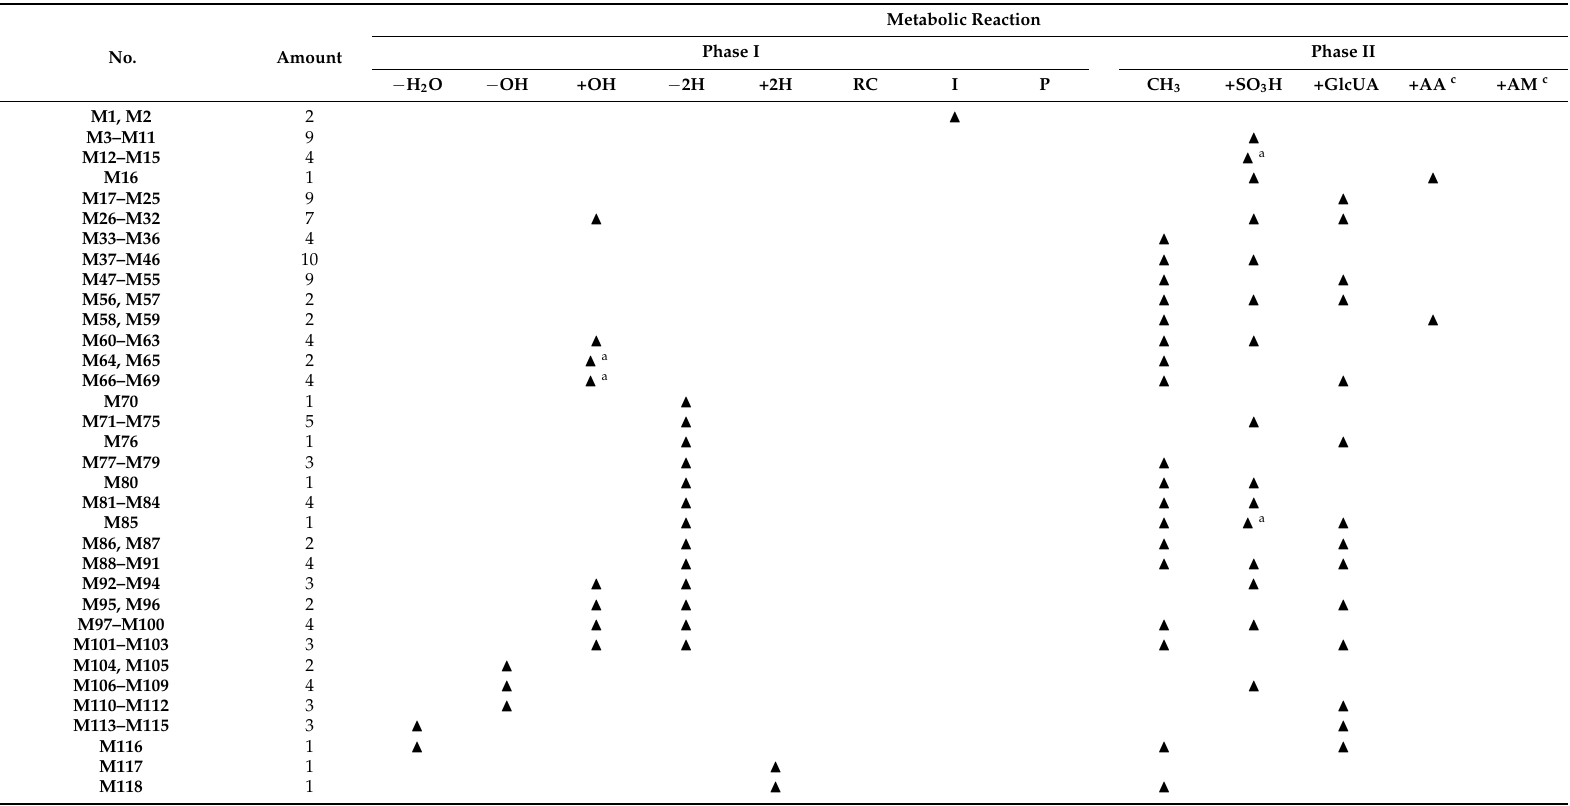
Table 2. Metabolic reactions forming 191 metabolites of taxifolin detected in